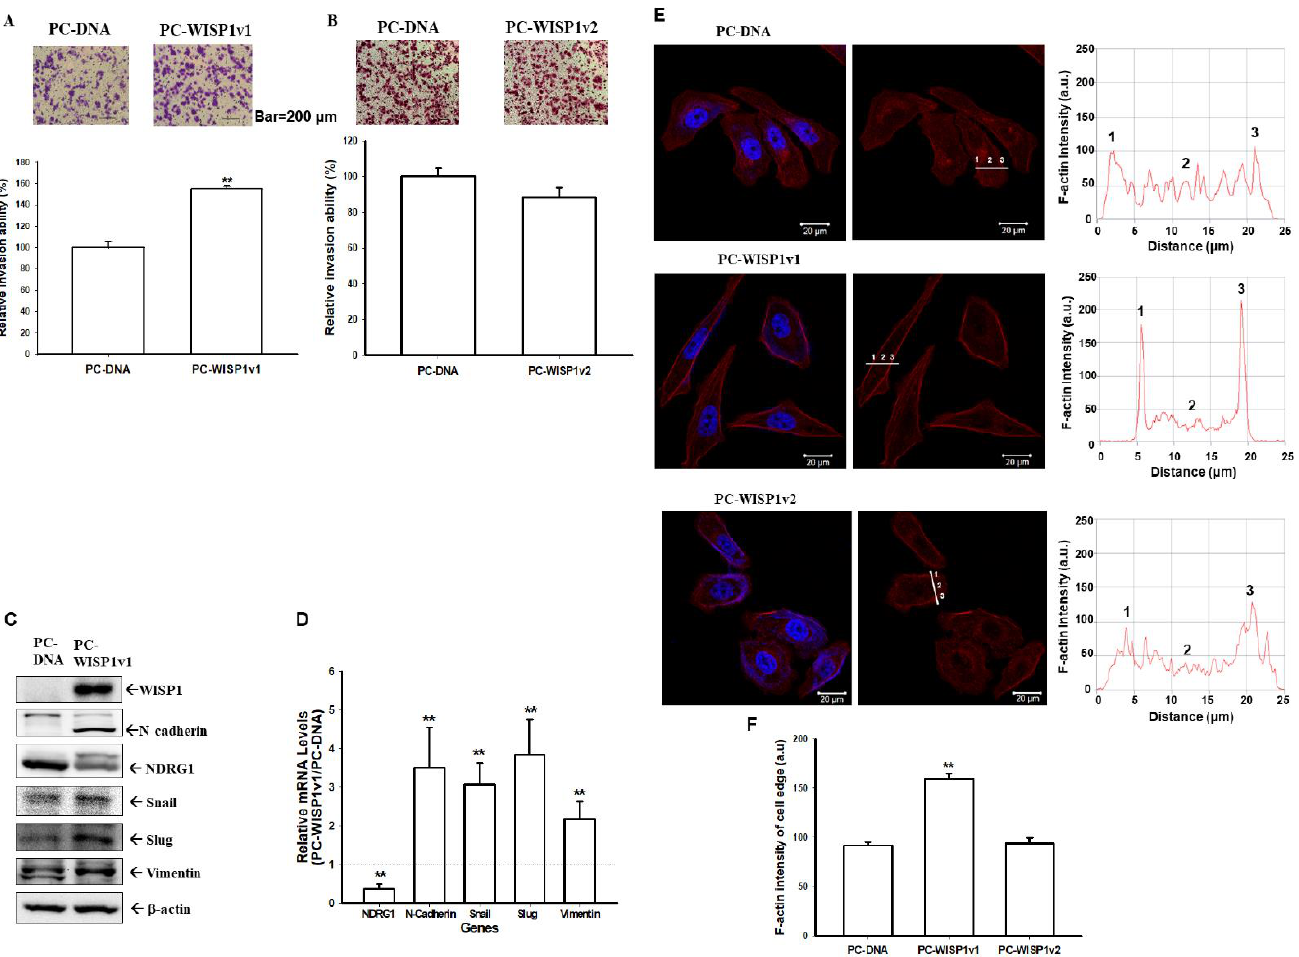
Figure 5. Modulating effect of WISP1v1 on the cell invasion in the prostate carcinoma PC-3 cells. The invasion ability of PC-3 cells after the ectopic overexpression of WISP1v1 ( A ) and WISP1v2 ( B ) was determined by in vitro Matrigel invasion assays. ( C ) The protein levels of NDRG1 and EMT markers (N-cadherin, snail, slug, vimentin) were determined by immunoblot assays. ( D ) The mRNA levels of the NDRG1 and EMT markers were determined by RT-qPCR. Data were presented as target genes/ β -Actin of PC-WISP1v1 cells relative to PC-DNA cells. ( E ) The F-actin staining with Texas Red X-Phalloidin and the immunofluorescence was recorded using a confocal microscope. ( F ) The intensities were measured along the line from the peripheral to the central of the cells, and the quantitative analysis of the F-actin fluorescence intensity of PC-DNA, PC-WISP1v1, and PC-WISP1v2 cells (±SE, n = 4). ** p < 0.01.